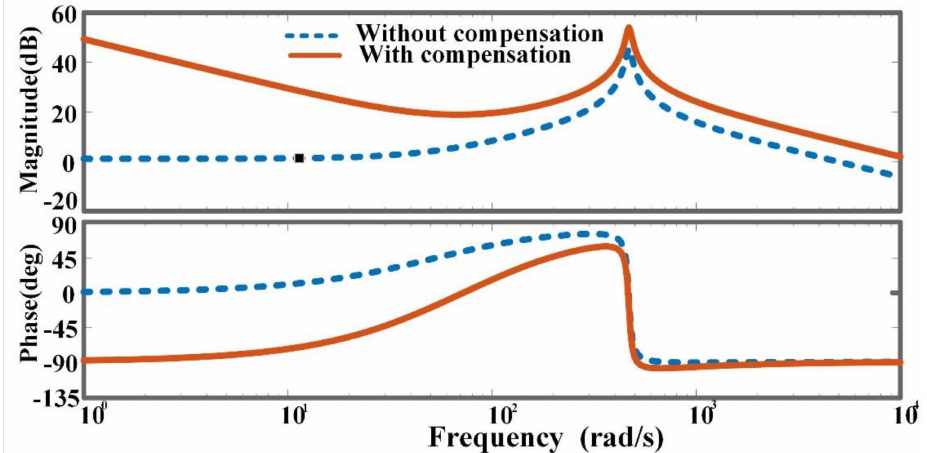
Figure 9. With and without correction, an open-loop Bode plot of battery current logic is shown.